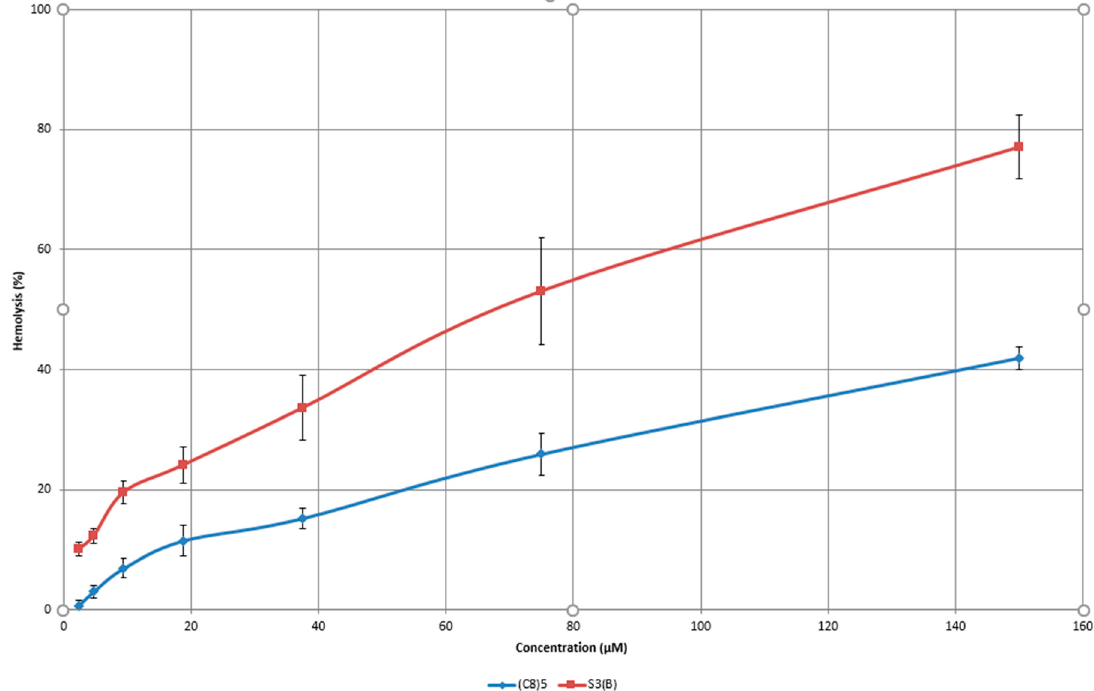
Figure 3. Hemolysis as a function of peptide concentration. In the present study, the peptide (C 8 ) 5 (blue curve) showed significant lower toxicity toward erythrocytes than S3(B) (red curve) in all tested concentrations (2.35–150 µ M). The results are presented as mean ± standard deviations ( n = 3).